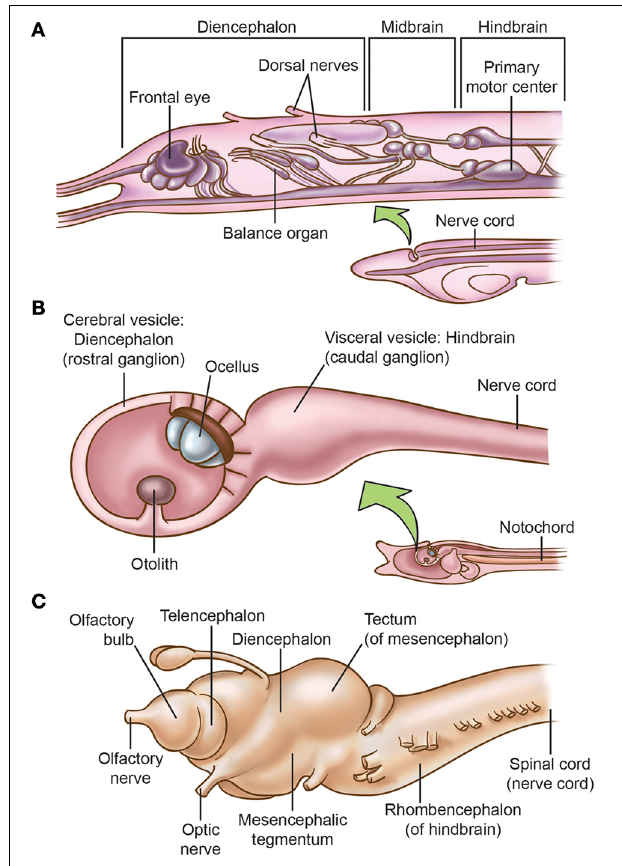
FIGURE 2 | Comparison of the brains of (A) larval amphioxus, (B) larval tunicate Ciona intestinalis , and (C) the lamprey Lampetra fluviatilis . In all three pictures, anterior is to the left. Based on Young (1962), Nieuwenhuys (1972, 1977), Burighel and Cloney (1997), Nieuwenhuys and Nicholson (1998), Fritzsch and Glover (2009), and Glover and Fritzsch (2009). Only the lamprey has a well-delineated tripartite brain and the full suite of neural-crest